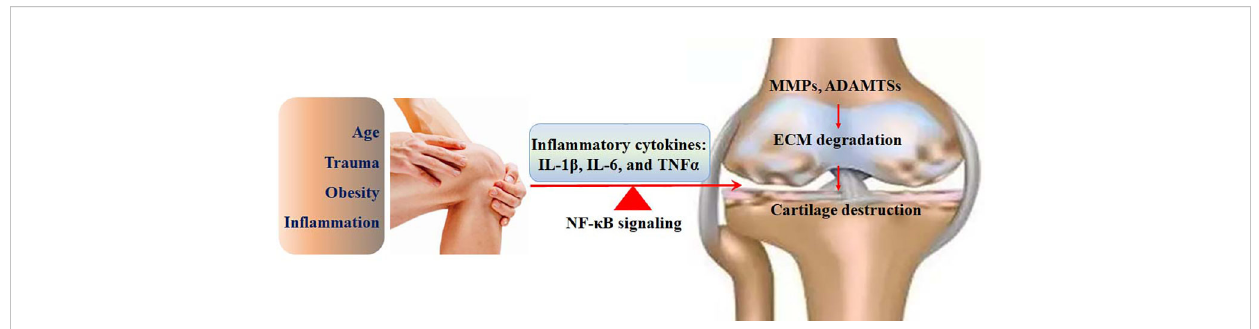
FIGURE 4 The involvement of the NF- k B signaling in the pathological development of OA. The risk factors, such as age, trauma, in fl ammation, and obesity, can activate the NF- k B signaling, which up regulates the expression of IL-1 b , IL-6, and TNF a . The expression of catabolic enzymes, such as MMPs and ADAMTSs is enhanced by the NF- k B signaling, followed by ECM degradation and cartilage